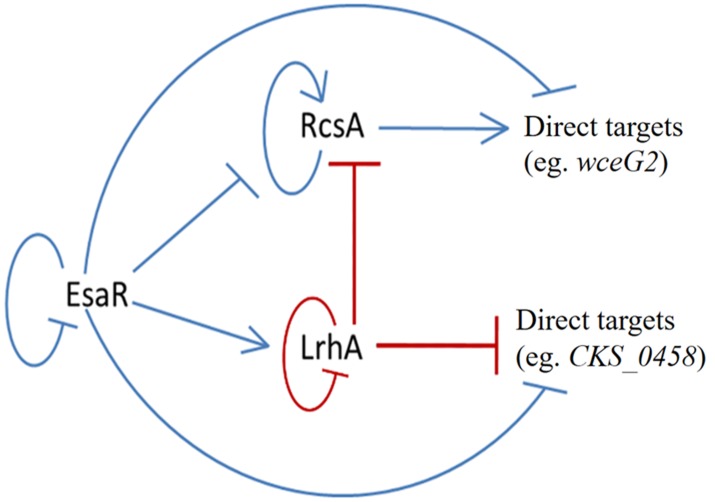
Updated model of the quorum-sensing regulatory network in P. stewartii.Solid lines indicate known direct regulatory control. Red lines indicate direct control found in this study. Arrows represent activation and T lines represent repression. At low cell density when AHL levels are low, EsaR represses expression of rcsA, wceG2, and CKS_0458, and activates expression of lrhA. LrhA represses its own expression as well as that of rcsA and CKS_0458. At high cell density when EsaR-AHL complexes form, EsaR no longer activates or represses its direct targets. Thus, rcsA expression increases leading to activation of wceG2 and other genes necessary for capsule production. See the text for additional details.